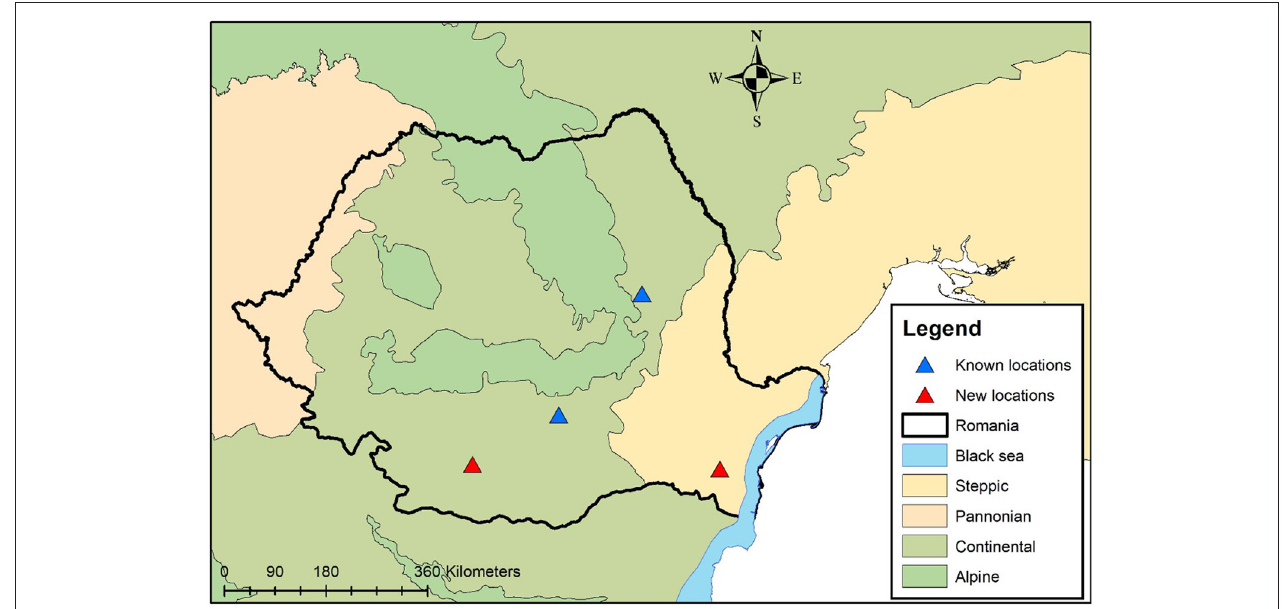
FIGURE 5 | Geographical distribution of O. lupi in domestic dogs from Romania. Blue triangles show previously reported cases. The red triangles show the two new possible